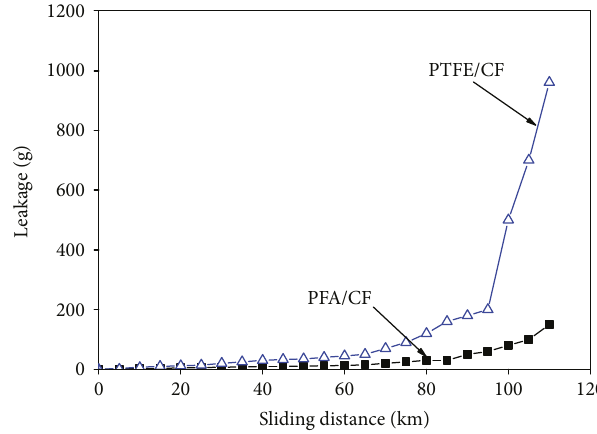
Figure 8: Leakage of PTFE/CF and PFA/CF seals with sliding distance.